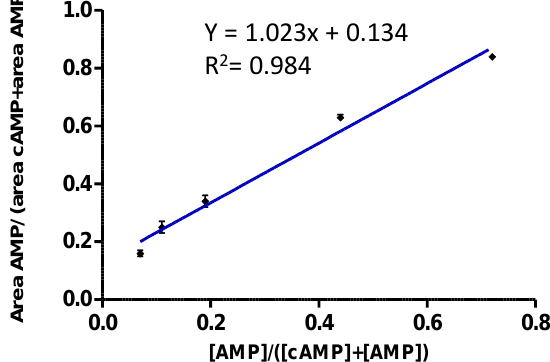
Figure 3. A correlation curve was performed using five solutions prepared at increasing concentrations, specifically 0.35, 0.87, 1.75, 2.6 and 3.5 pmol/μL for cAMP and 0.25, 0.32, 0.4, 0.7 and 0.9 pmol/μL for AMP ( n = 4).